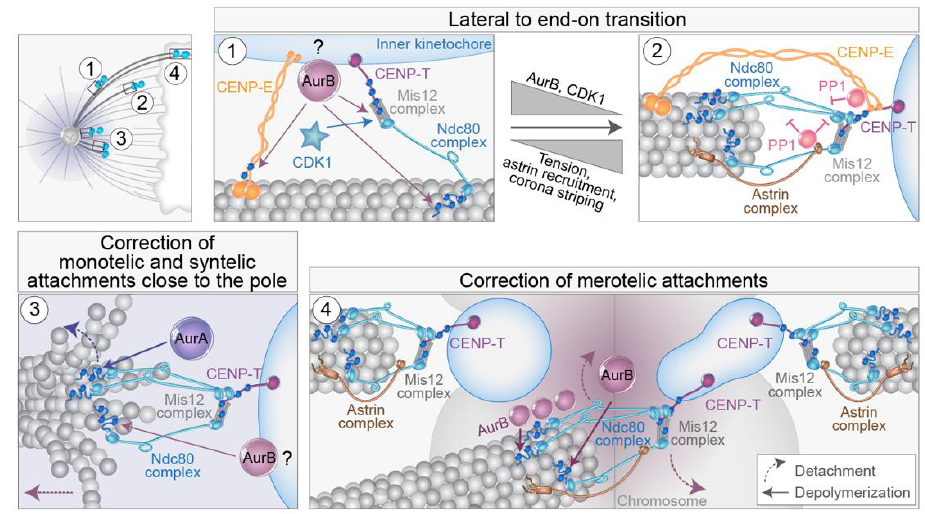
Figure 6. Mechanisms that control the lateral to end-on transition and error correction in different spindle regions. Different attachment types from the scheme at the top left are enlarged in panels (1)–(4). (1) and (2) Simplified view of the main molecular machinery that regulates the transition from lateral (1) to end-on (2) attachment of kinetochores to microtubules. The spindle assembly checkpoint is turned on in (1) and turned off in (2). A pool of Aurora B is present at the outer kinetochore, although the kinetochore receptor for this pool is unknown (“?”). (3) Simplified view of the main molecular machinery that regulates the correction of monotelic and syntelic attachments close to the spindle pole in the gradient of Aurora A activity (same color as the circled AurA), and (4) the correction of stretched merotelic attachments in the gradient of centromeric Aurora B activity (same color as the circled AurB) or by the Aurora B diffusing along the microtubule that originates from the distant pole (small Aurora B circles). Arrows from Aurora kinases denote phosphorylation of various kinetochore targets. Dashed arrows from kinetochore targets denote either detachment (curved arrows) or depolymerization (straight arrows) (legend in part 4). Small blue dots represent phosphorylated residues. AurA, Aurora kinase A; AurB, Aurora kinase B.